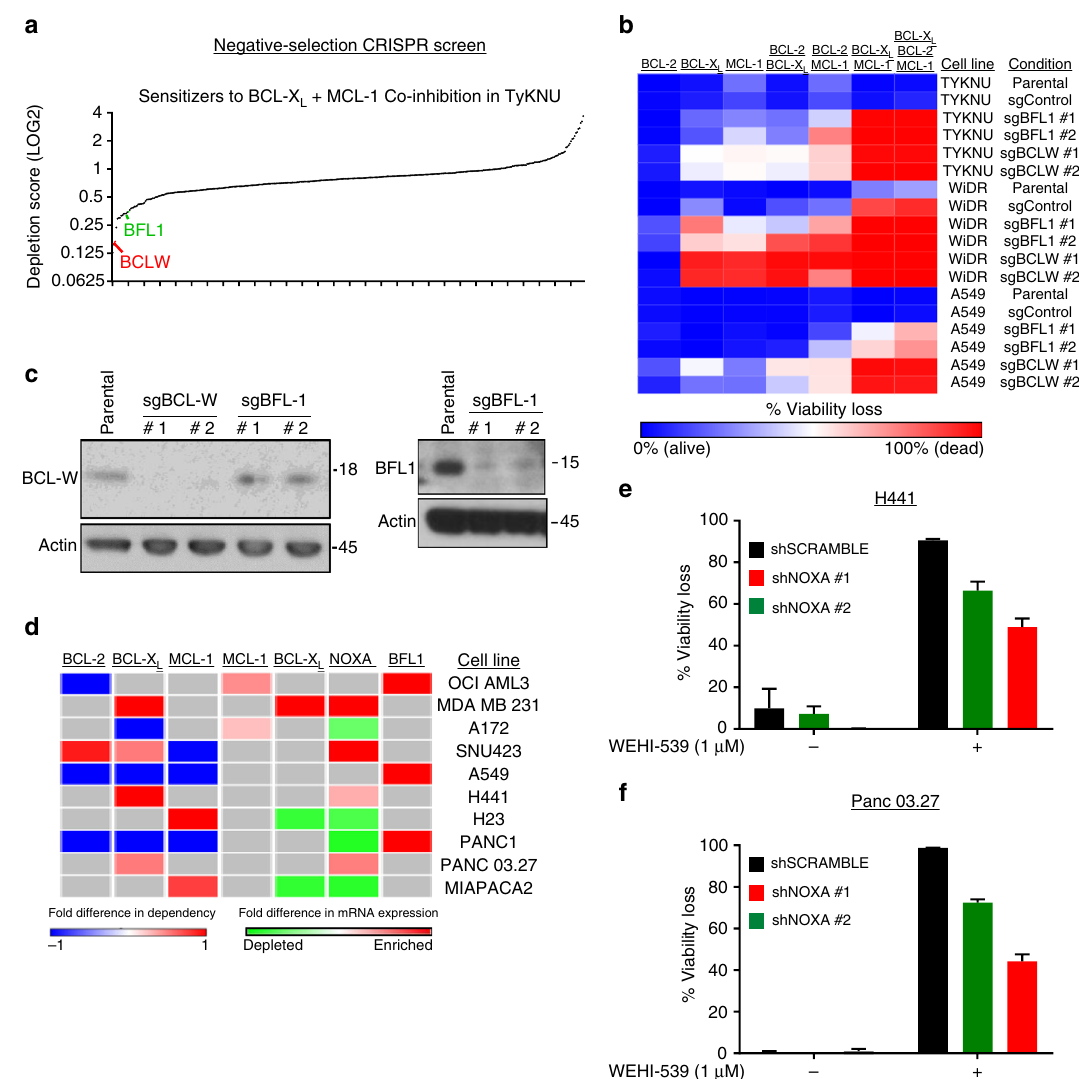
Fig. 6 BCL-w and BFL-1 promote intrinsic resistance to BCL-X L + MCL-1 inhibition. a A negative-selection CRISPR screen to identify sensitizers to combined BCL-X L + MCL-1 inhibition in a resistant cell line. The resistant cell line, TYKNU, was transduced with a CRISPR library containing cancer-relevant genes and grown in either vehicle (DMSO) or WEHI-539 (1 µ M) + A-1210477 (10 µ M) for 2 weeks. Genes whose depletion sensitized to the co-inhibition of BCL-X L + MCL-1 were deconvoluted via deep-sequencing of the barcoded CRISPR libraries from each sample. LOG 2 values of the depletion mean (DM) scores were plotted and relevant apoptotic genes were highlighted: red, BCL-w and green, BFL-1. b Validation of hits from screen. Three resistant cell lines (TYKNU, WiDR, and A549) were transduced for either control or sgRNAs that targeted BFL-1 or BCL-w. The cells were treated with the BH3 mimetic panel and assessed for viability loss after 3 days in drug. c Example of gene ablation. For a representative cell line (A549), knockout of BFL-1 or BCL-w was assessed via western blotting d Overlap of outlier phenotype data (BCL-2 gene dependencies) vs outlier mRNA expression. The dependency scores of BCL- 2, BCL-X L , and MCL-1 from each outlier cell line were compared to the average scores from the matched tissue type and plotted in a heatmap. Red or blue indicates an increased or decreased dependency score respectively in that cell line compared to the average score for that tissue. For each cell line, the average gene expression data for these genes was compared to the average for that tissue type, and plotted as enriched (red) or depleted (green) relative to tissue-average. e , f Genetic validation of outlier expression vs outlier phenotype. Two cell lines were selected: H441 cells, which are more dependent on BCL-X L than other LUAD lines and have above-average NOXA expression, and Panc 03.27 cells, which are more dependent on BCL-X L than other PAAD lines and have above-average NOXA expression. In both lines, NOXA was depleted and cells were assessed for sensitivity to the BCL-X L inhibitor( n = 3) and data are presented as mean viability loss ±